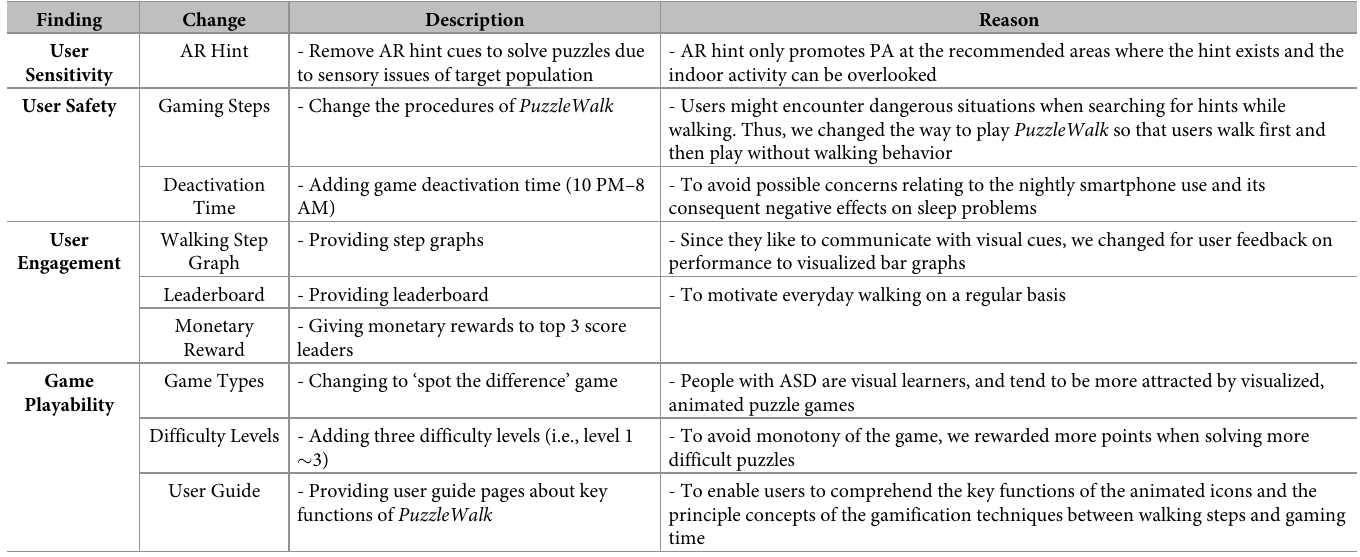
Table 1. From high-fidelity to functional prototype: Revised functions based on iterative participatory